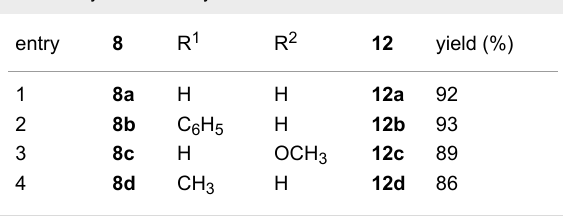
Table 3: Synthesis of acrylates 12